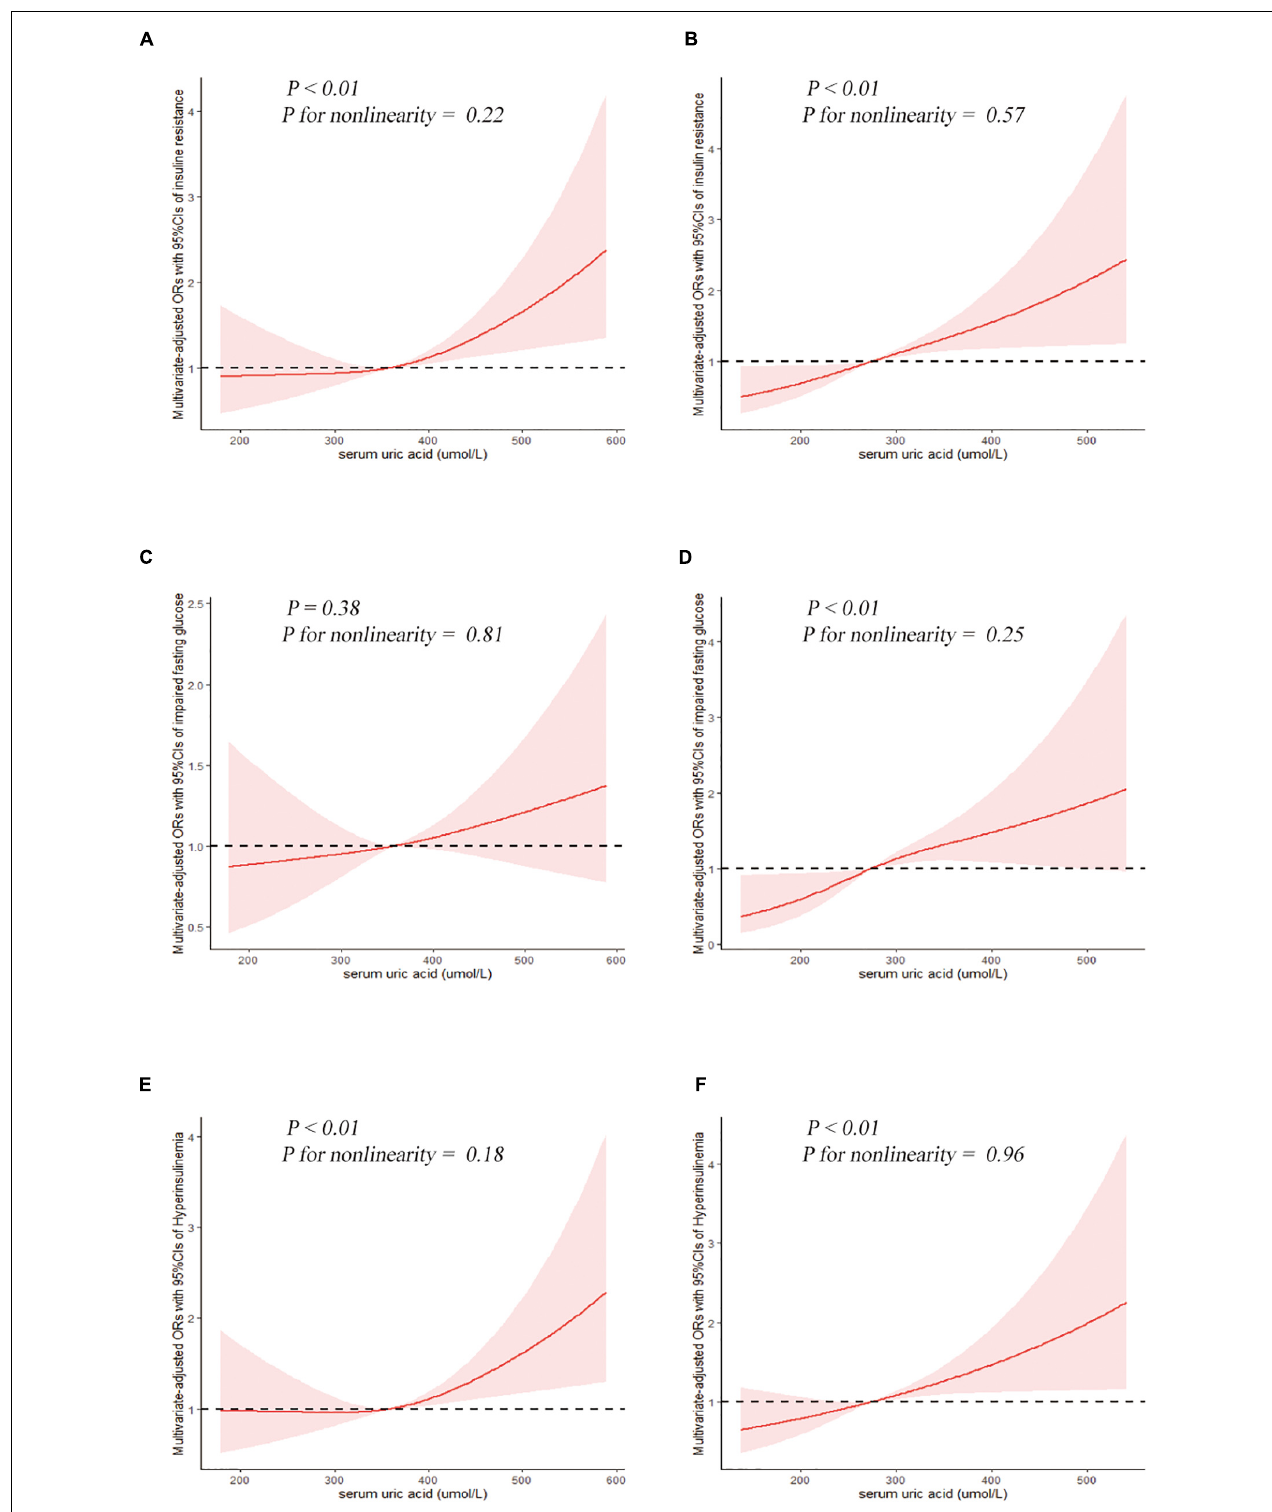
FIGURE 2 | Examination of the dose-response relationship between serum uric acid ( µ mol/L) and the risk of impaired glucose metabolism by restricted cubic splines model. The restricted cubic splines model adjusted for race, BMI, waist circumference, drinking status, education level, hypertension, total cholesterol, triglyceride, and urate-lowering therapy. Insulin resistance, (A) men and (B) women. Impaired fasting glucose, (C) men and (D) women. Hyperinsulinemia, (E) men and (F) women.